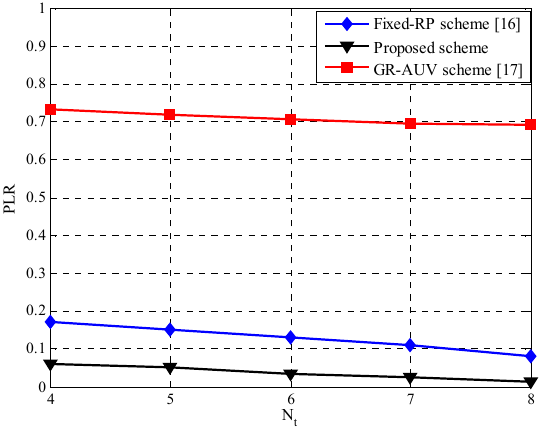
Figure 15. Packet loss ratio versus the number of tour-points, N t .